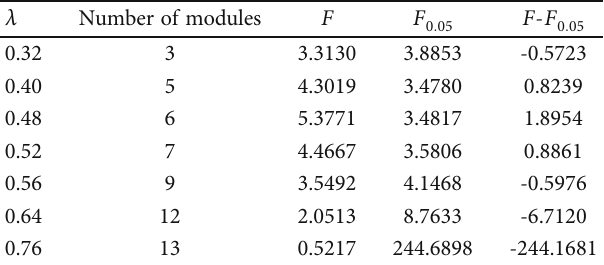
Figure 8: Community division hierarchy. Table 7: F - statistic